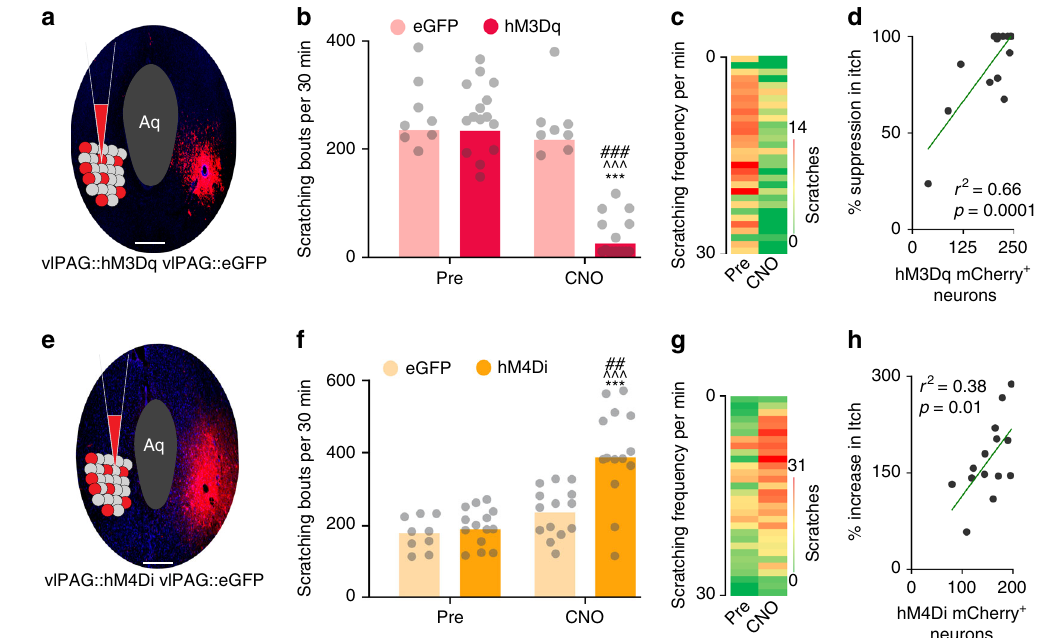
Fig. 2 Chemogenetic manipulation of vlPAG neurons can modulates itch. a Schematic and representative coronal section image showing viral targeting of AAV8 hM3Dq – mCherry transgenes bilaterally injected into the vlPAG, scale bar represents 375 µ M. b CNO (1 mg/kg, i.p) administration resulted in a signi fi cant reduction in chloroquine evoked scratching in hM3Dq injected mice. Relative to pre-treatment control values, CNO (1 mg/kg, i.p) did not have any effects on the number of scratches induced by chloroquine injection in mice expressing the control eGFP construct Interaction; F (1, 21) = 25.24, *** P < 0.0001. Pre vs. CNO; F (1, 21) = 37.49, ^^^ P < 0.0001. eGFP vs. hM3Dq; F (1, 21) = 25.65, ### P < 0.0001. N = 15 for hM3Dq and N = 8 for eGFP group. Two-way ANOVA. c Heat map showing per-minute averaged chloroquine-evoked scratching bouts pre-CNO and post-CNO in mice expressing hM3Dq in the vlPAG. d Reduction in chloroquine evoked scratching in hM3Dq injected mice after CNO administration is directly correlated with number of hM3Dq- mCherry + vlPAG neurons. R 2 = 0.66, P = 0.0001. e Illustration and representative image of coronal section containing vlPAG demonstrating restricted viral expression following microinjection of the AAV8 hM4Di-mCherry into the vlPAG, scale bar represents 305 µ M. f CNO (1 mg/kg, i.p) administration resulted in a signi fi cant increase in chloroquine evoked scratching in hM4Di injected mice but not in control mice that express eGFP construct. Interaction; F (1, 23) = 17.03, *** P = 0.0004. Pre vs. CNO; F (1, 23) = 22.77, ^^^ P < 0.0001. eGFP vs. hM4Di; F (1, 23) = 9.915, ## P = 0.0045. N = 14 for hM4Di and N = 11 for eGFP control. Two-way ANOVA. g Heat map showing per-minute averaged chloroquine-evoked scratching bouts pre-CNO and post-CNO in mice expressing hM4Di in the vlPAG. h Increase in chloroquine evoked scratching in hM4Di injected mice after CNO administration is directly correlated with number of hM4Di-mCherry + vlPAG neurons. R 2 = 0.38, P = 0.01. All values are mean ± SEM. Source data are available as a Source Data fi